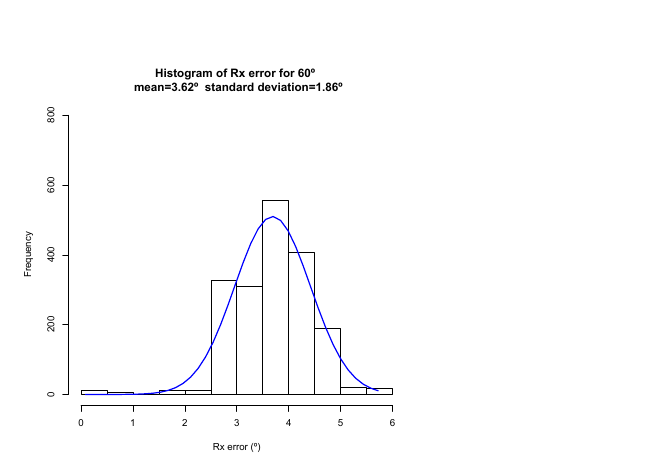
Figure 27. Histogram of Z e error when the target is placed within the limit of the field of view of the camera. The curve in blue is the curve estimated by R as the Gaussian curve that is closest to the obtained data.